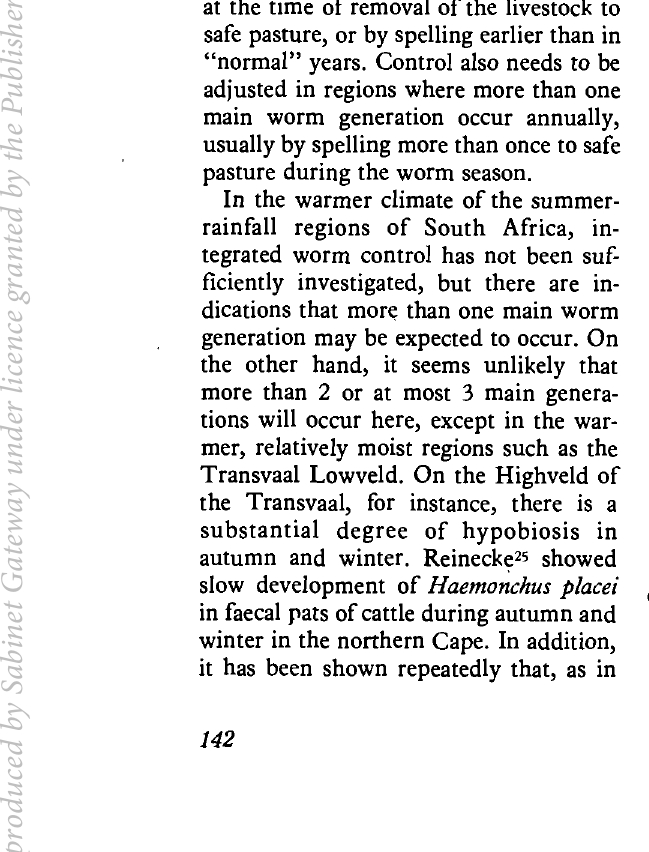
for alternatives, is the alternate use of pasture for animals of different species which are not susceptible to one another's worm